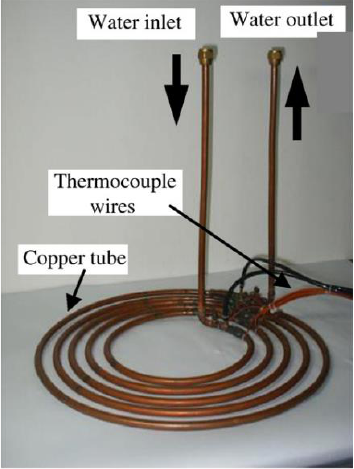
Figure 4. The physical model of spiral-coil tube.